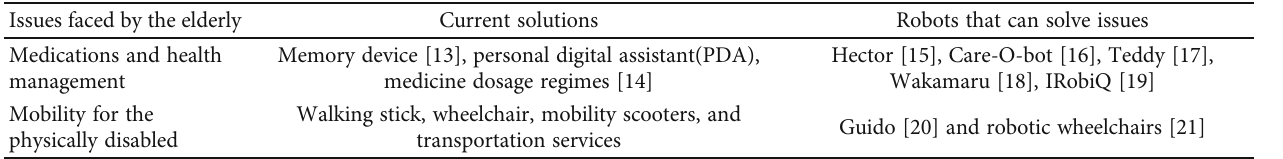
Table 1: Examples of conditions assisted with